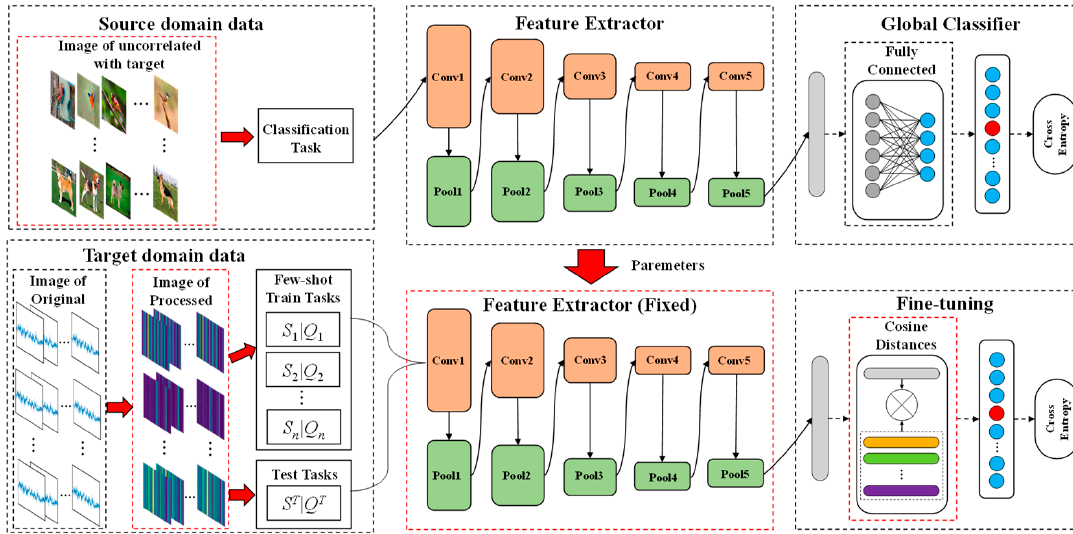
Figure 3. Fault diagnosis